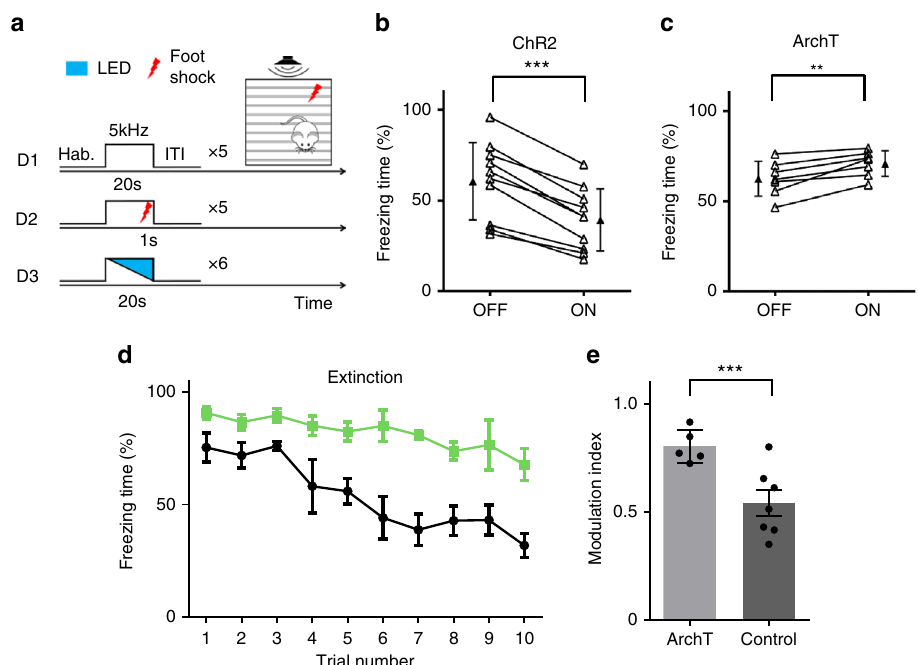
Fig. 4 ZIr bidirectionally modulates conditioned freezing response. a Experimental paradigm for fear conditioning and testing of learned freezing response. b Percentage of time freezing during presentations of CS alone without and with activation of ZIr. *** p < 0.001, two-sided paired t -test, n = 10 animals. c Percentage of time freezing during presentations of CS alone without and with suppressing ZIr. ** p = 0.005, two-sided paired t -test, n = 7 animals. d Percentage of time freezing at each presentation of CS during extinction training with (green) and without (black) suppressing ZIr. Scale bar = s.e., n = 5 for ArchT and 7 for control. e Modulation index calculated for each animal (as the ratio of freezing time between the last and fi rst trial) for the GFP control and ArchT suppression group. *** p = 0.004, two-sided unpaired t -test, n = 5 for ArchT and 7 for control. Solid symbol represents mean ± s.d. for all